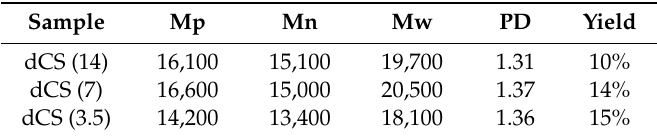
Table 3. Average molecular weights of the dCS sample purified with dialysis over 3 days using membranes of 14, 7 and 3.5 kDa MWCO.